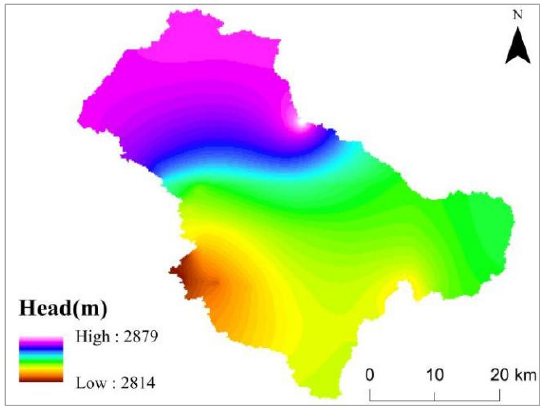
Figure 7. Initial groundwater head for MODFLOW.